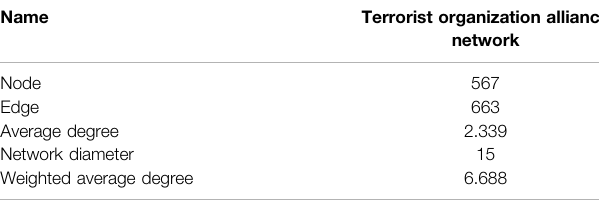
TABLE 1 | The statistical features of terrorist organization alliance network.